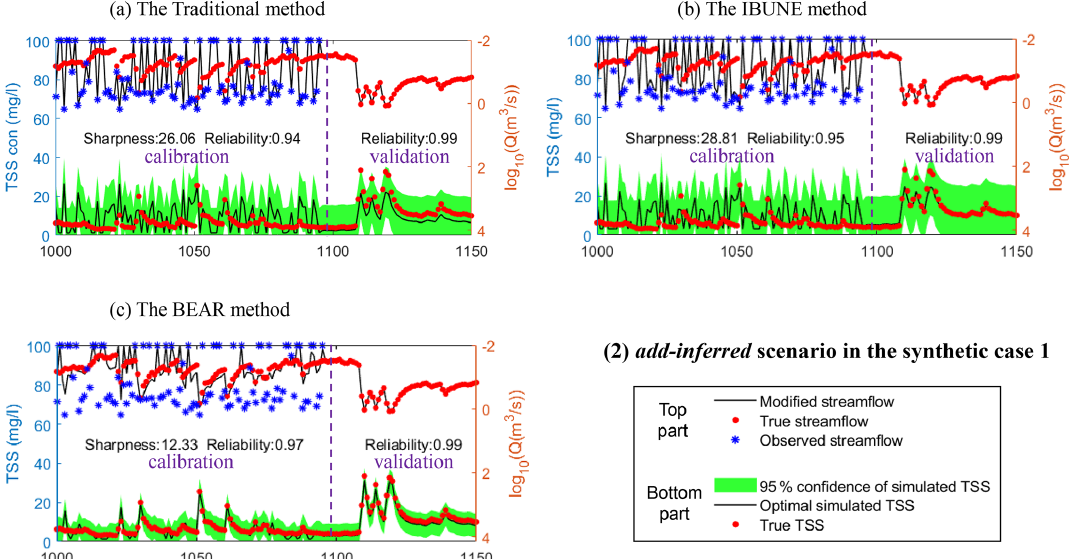
Figure B2. Comparison of the time series of synthetic data and uncertainty bands estimated via three calibration methods (including the traditional method, the IBUNE method, and the BEAR method; algorithms are explained in Sect. 2.4) for a select period of the add-inferred scenario in synthetic case 1 (notations are given in Table